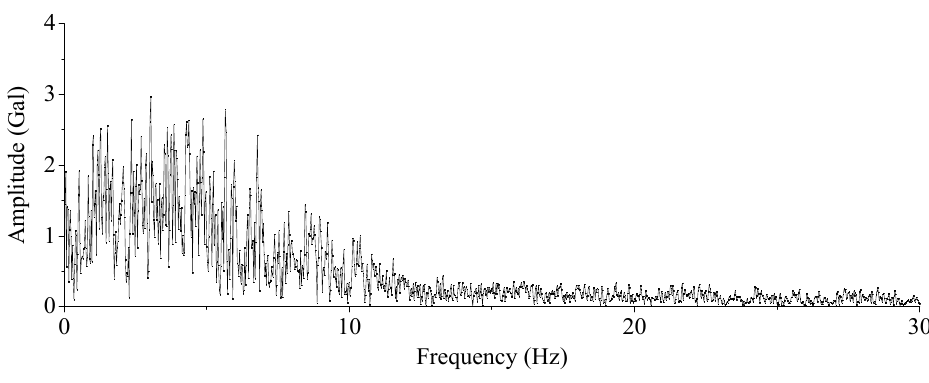
Figure 9. Fourier spectrum of time history curve of accelerometer A4.